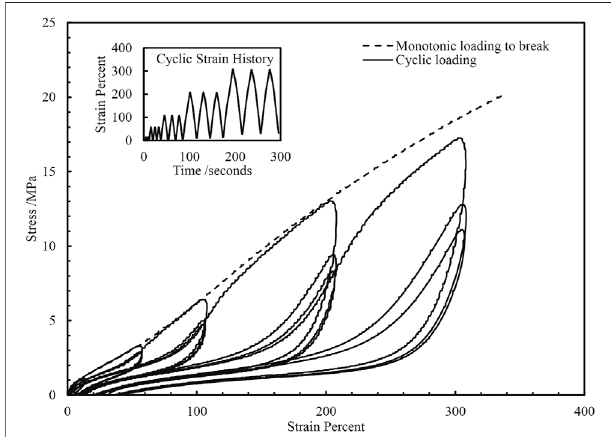
FIGURE 1 | Complex stress-strain behavior observed in 50 parts per hundred(phr)N550carbonblackreinforcednaturalrubberundercyclictensile extension. Tests were done at a rate of 500 mm/min at room